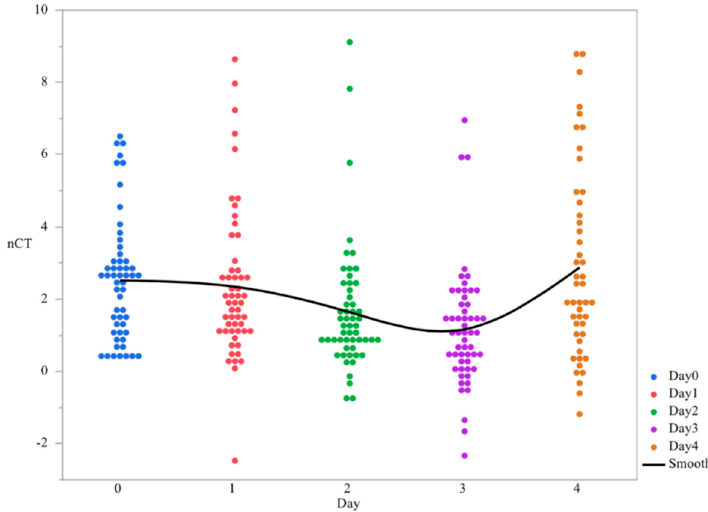
Figure 1. Changes in expression of the gene csgD from planktonic cells used to form Salmonella pellicles over a 4-days time period 1 . qRT-PCR was performed on total RNA isolated from bacterial cultures of Salmonella as pellicles were being formed over a 4-day time period. 1 N = 270, n = 54, p < 0.0001, Individual SEM for day 0, 1, 2, 3, and 4 was 0.231, 0.285, 0.242, 0.226, and 0.387 respectively.